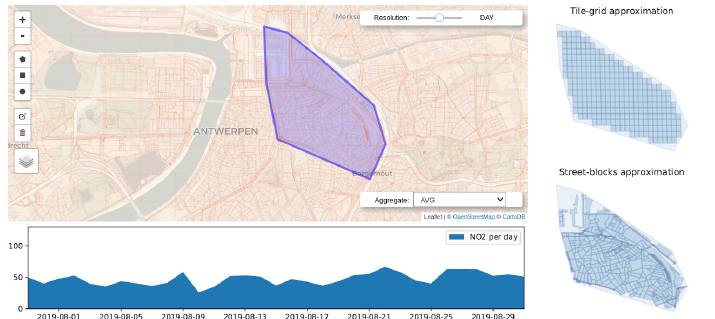
Figure 8. Application allowing users to examine the change over time of an air quality measure on a certain geospatial region: Notice at the right hand side how tiles and street-blocks would approximate the area of the provided polygonal selection.